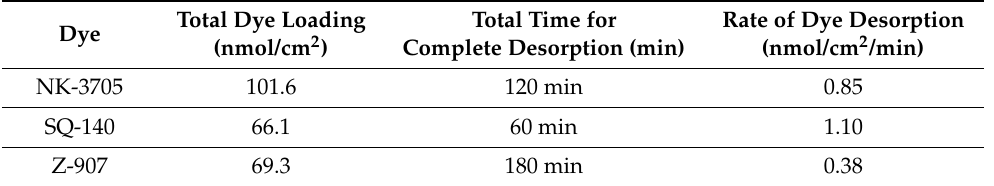
Table 1. Dye desorption behaviour on TiO 2 -coated FTO glass substrate with an area of 6.25 cm 2 and thickness of 14 µ